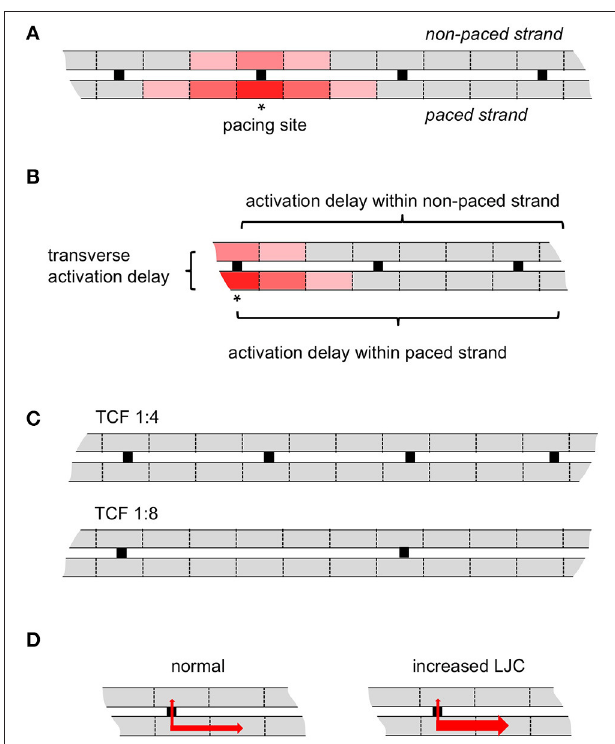
FIGURE 1 | Schematic representation of the model. (A) Two parallel myocyte cables, in this case with a 1:4 discrete transverse connectivity ratio. Pacing (asterisk) was always delivered from middle of the lower strand (paced strand); the upper strand is non-paced strand. (B) The transverse activation delay is defined as the conduction time difference between the paced myocyte and the direct opposite myocyte in the non-paced strand; the activation delay within a strand is defined as the activation difference between 1st (stimulation site for paced strand or the direct opposite myocyte in non-paced strand) and 50th myocytes. (C) As an example, the transverse connectivity fraction (TCF) 1:4 and 1:8 are displayed here. (D) As an illustration for the longitudinal junctional conductance (LJC), the transverse conductivity is kept same but the longitudinal conductivity in both strands is